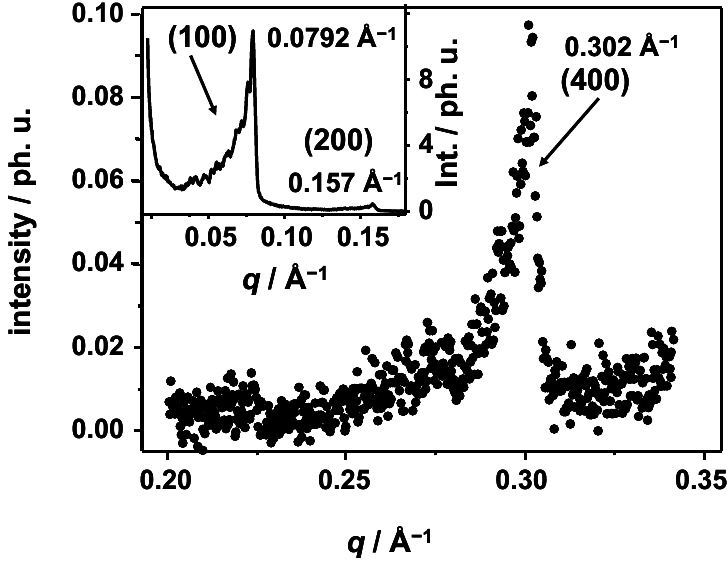
Figure 2. Experimental small angle X-ray scattering (SAXS) pattern for the ternary E /paraffin/glycerol/formamide at room temperature. The main graph shows mixture C 16 7 the (400), as measured with the apparatus extension. The inset graph shows the (100) and (200) Bragg reflection